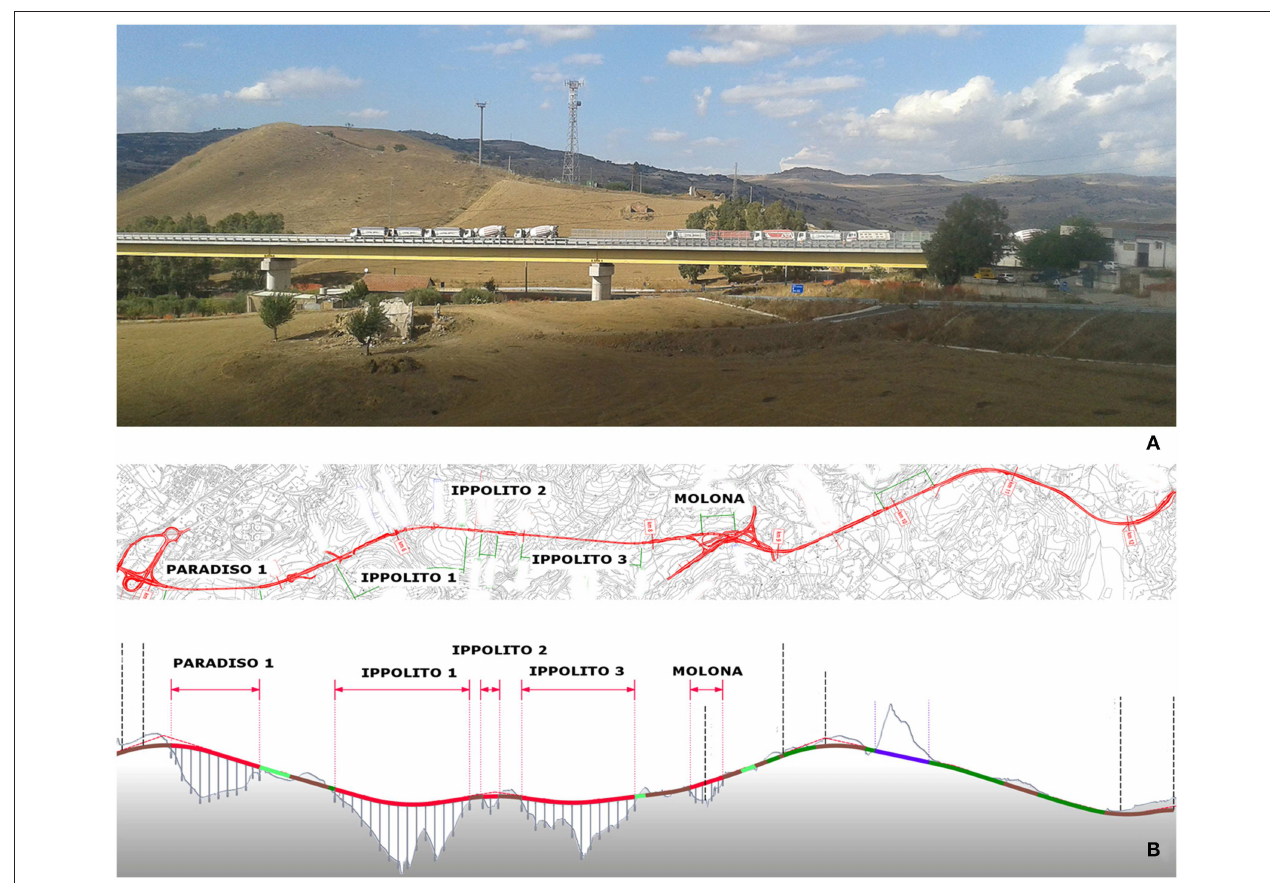
FIGURE 1 | (A) The Ippolito1 Viaduct during the load test; (B) “Caltagirone Variant”: plant and longitudinal section of the fast-flowing